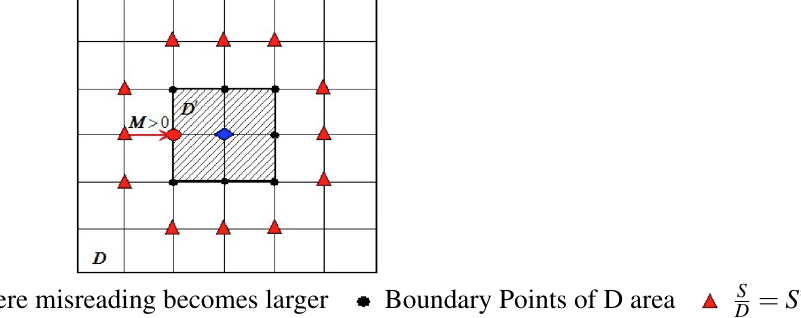
Fig. 3 Misreading variable large correction diagram of radiation dosage